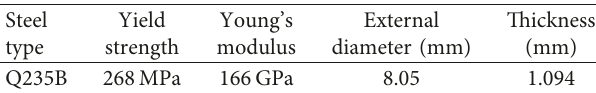
Figure 3: Details of the measuring points. (a) Measuring point of strain gages; (b) measuring points of accelerometer and displacement sensor. Table 3: Results of the material